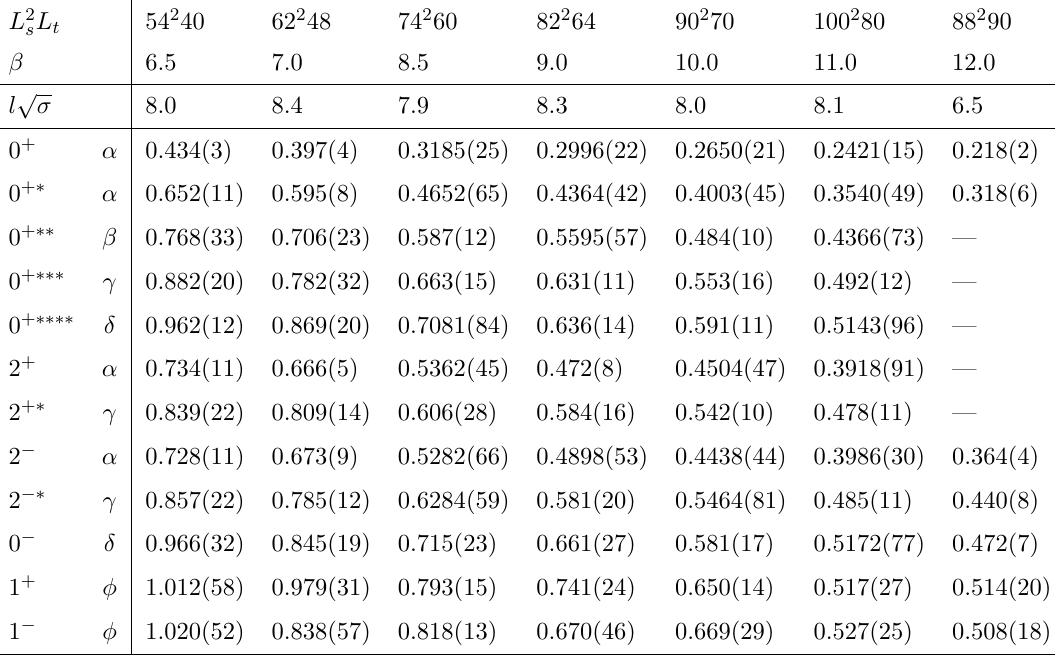
Table 20 . SO(3) glueball masses am G . Grades, e.g. (cid:11) , explained in section 3.6.6.